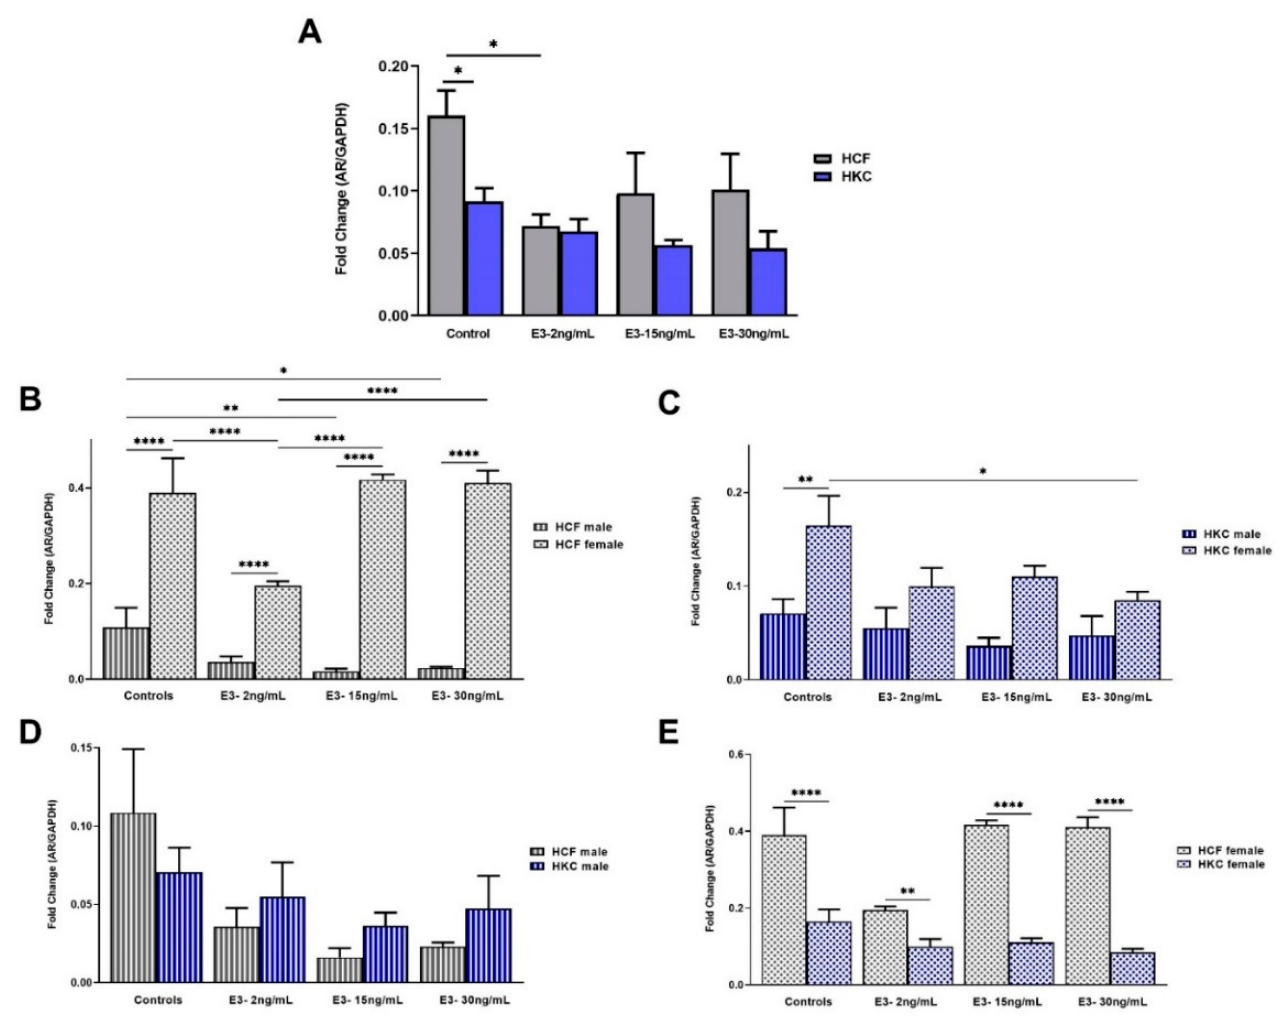
Figure 5. Expression of AR in 3D HCFs and HKCs in response to 2, 15, 30 ng/mL E3 stimulation for four weeks. ( A ) Overall AR expression in HKCs and HKCs ( n = 6). ( B ) Sex-specific expression of AR in HCFs ( n = 3). ( C ) Sex-specific AR expression in HKCs ( n = 3). ( D ) Male-specific AR expression in HCFs vs. HKCs ( n = 3). ( E ) Female-specific expression of AR in HCFs vs. HKCs. * p < 0.05, ** p < 0.01, and **** p < 0.0001.